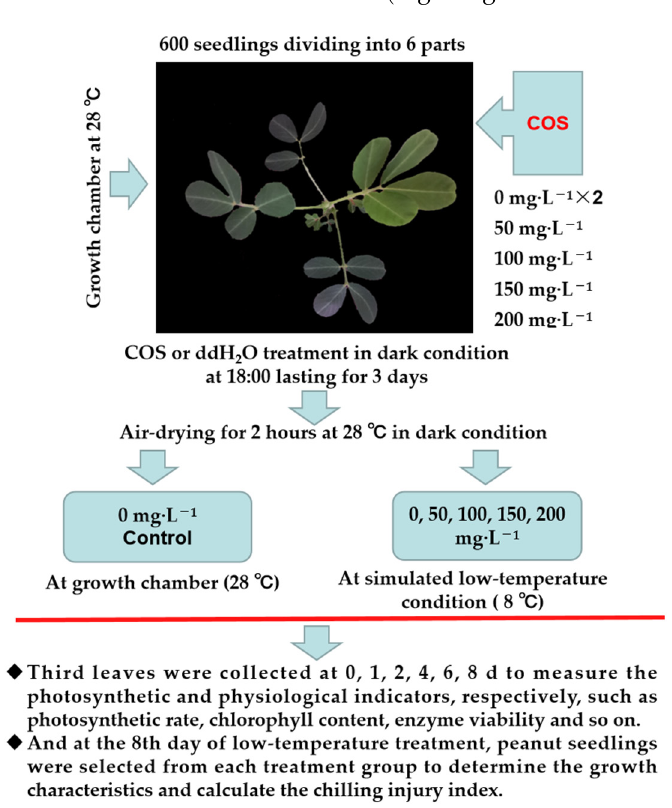
Figure 1. Schematic representation of the simulated cryogenic experimental design.